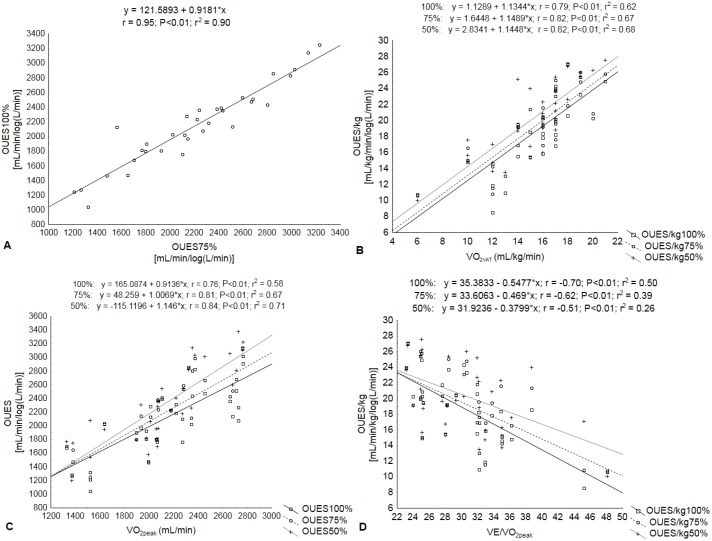
Simple linear regression equation and correlation coefficient showing the relationship between OUES (50%, 75%, 100%) and cardiorespiratory variables during CPX in morbidly obese women.A, OUES100%-OUES75%. B, OUES/kg50%,75%,100%-VO2VAT. C, OUES50%,75%,100%-VO2peak. D, OUES/kg50%,75%,100%-VE/VO2peak. OUES, oxygen uptake efficiency slope; VO2VAT, oxygen consumption at ventilatory anaerobic threshold; VO2peak, oxygen consumption at peak exercise; VE/VO2peak, ventilatory equivalent ratio for oxygen at peak exercise.